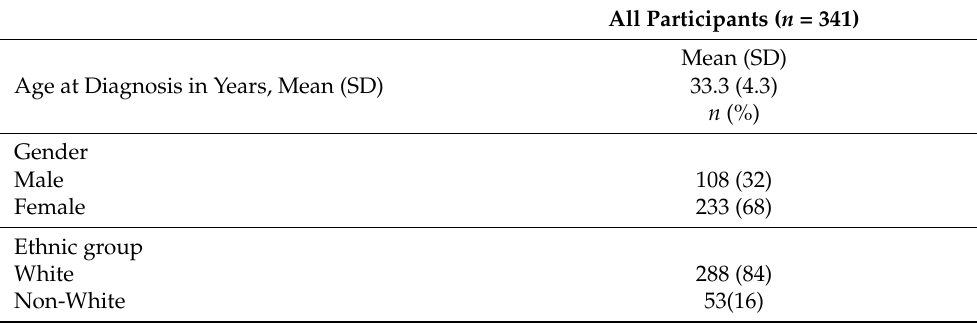
Table 1. Participant characteristics at time of